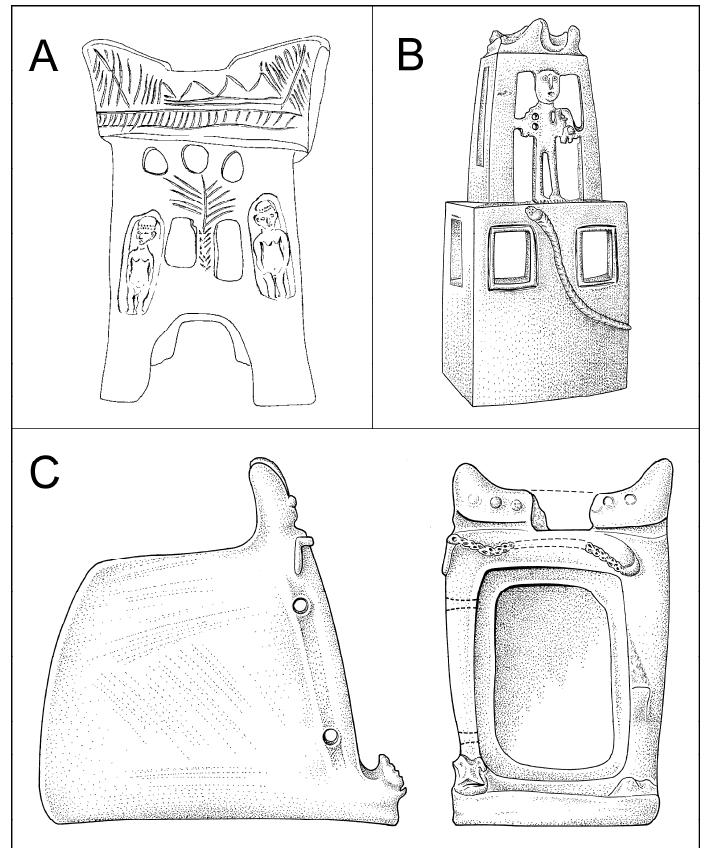
Figure 1. Typology of the main types of the objects commonly known as building models: ( A ). tower-like altar (Tel Rehov; Mazar and Panitz-Cohen 2008, p. 43); ( B ). model building (Beth-Shean; Rowe 1940); ( C ). closed box (Tel Rekhesh; Garfinkel and Mumcuoglu 2015).